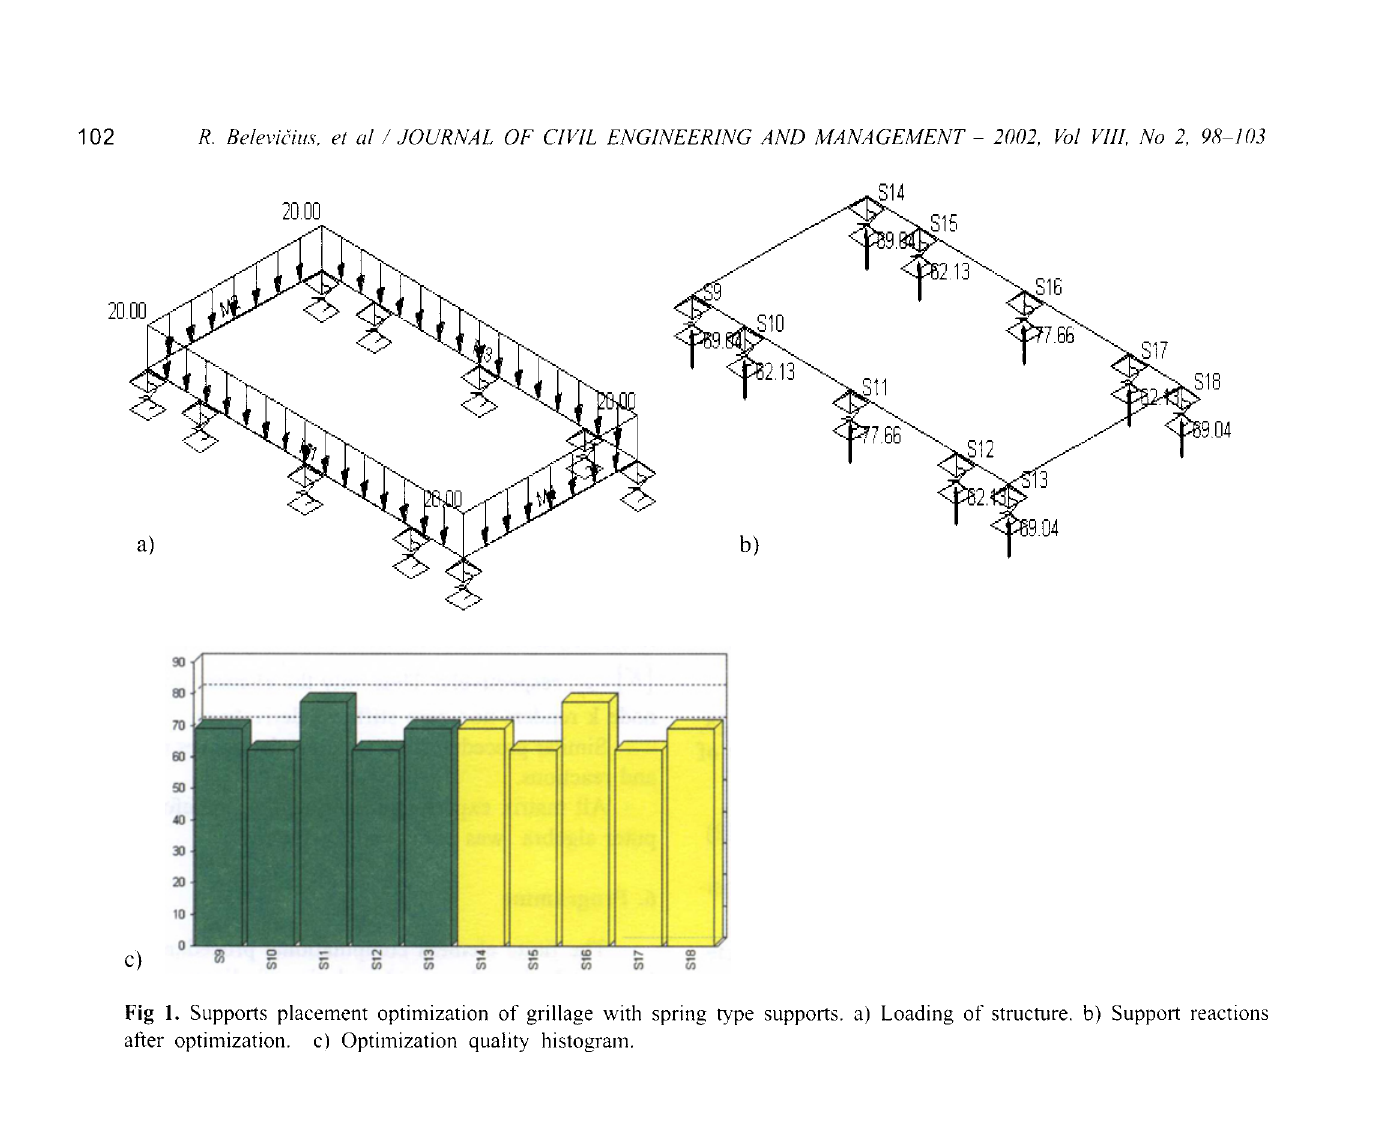
Fig I. Supports placement optimization of grillage with spring type supports. a) Loading of structure. b) Support reactions atler optimization. c) Optimization quality histogram.